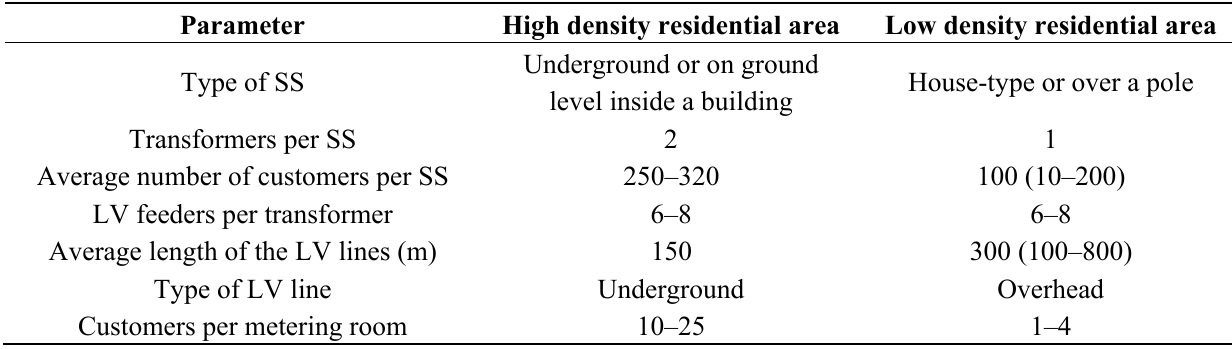
Table 1. Typical data for electricity grids in Europe. SS: Secondary Substation; and LV: Low